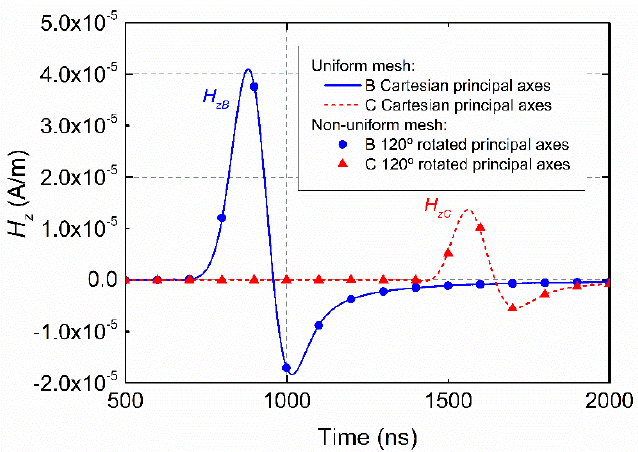
Figure 15. Magnetic field H z at points B and C in Figures 11 and 14—obtained using a uniform mesh with principal axes oriented along the Cartesian axes, compared with results obtained using a non-uniform mesh with principal axes rotated by 120° with respect to the Cartesian ones.